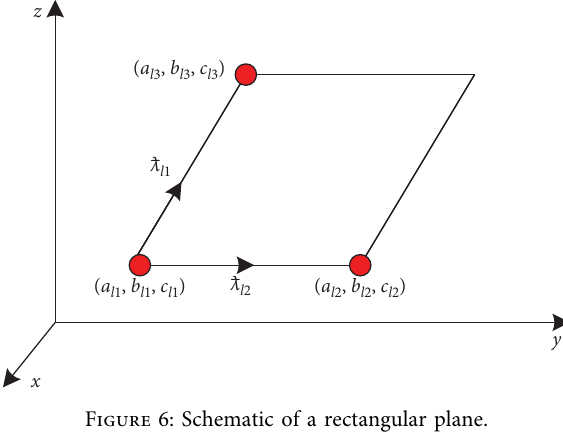
Figure 6: Schematic of a rectangular